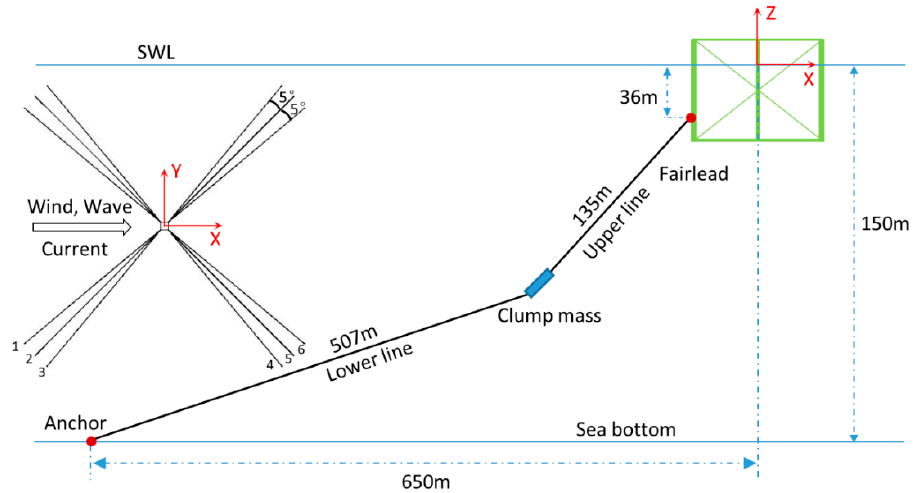
Figure 3. Mooring system layout.